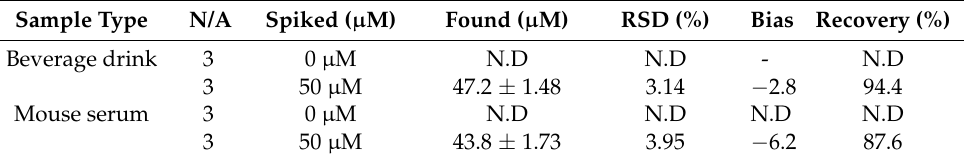
Table 1. Results of real sample analysis with a Co 3 O 4 -ZnO nanorod by the electrochemical method. Sample Type